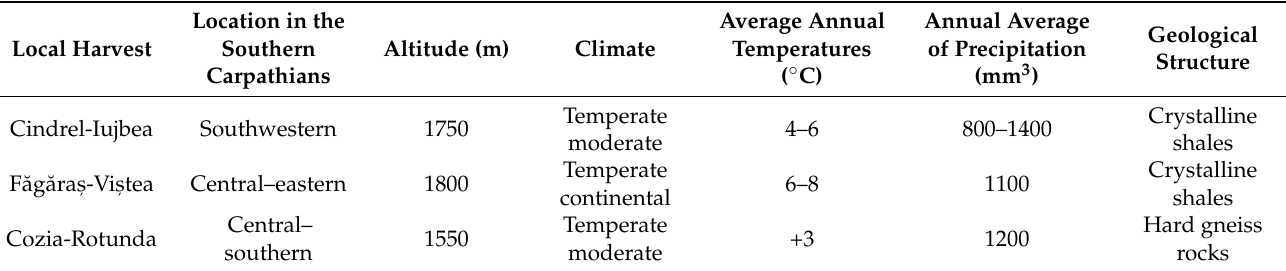
Table 1. Harvest details in